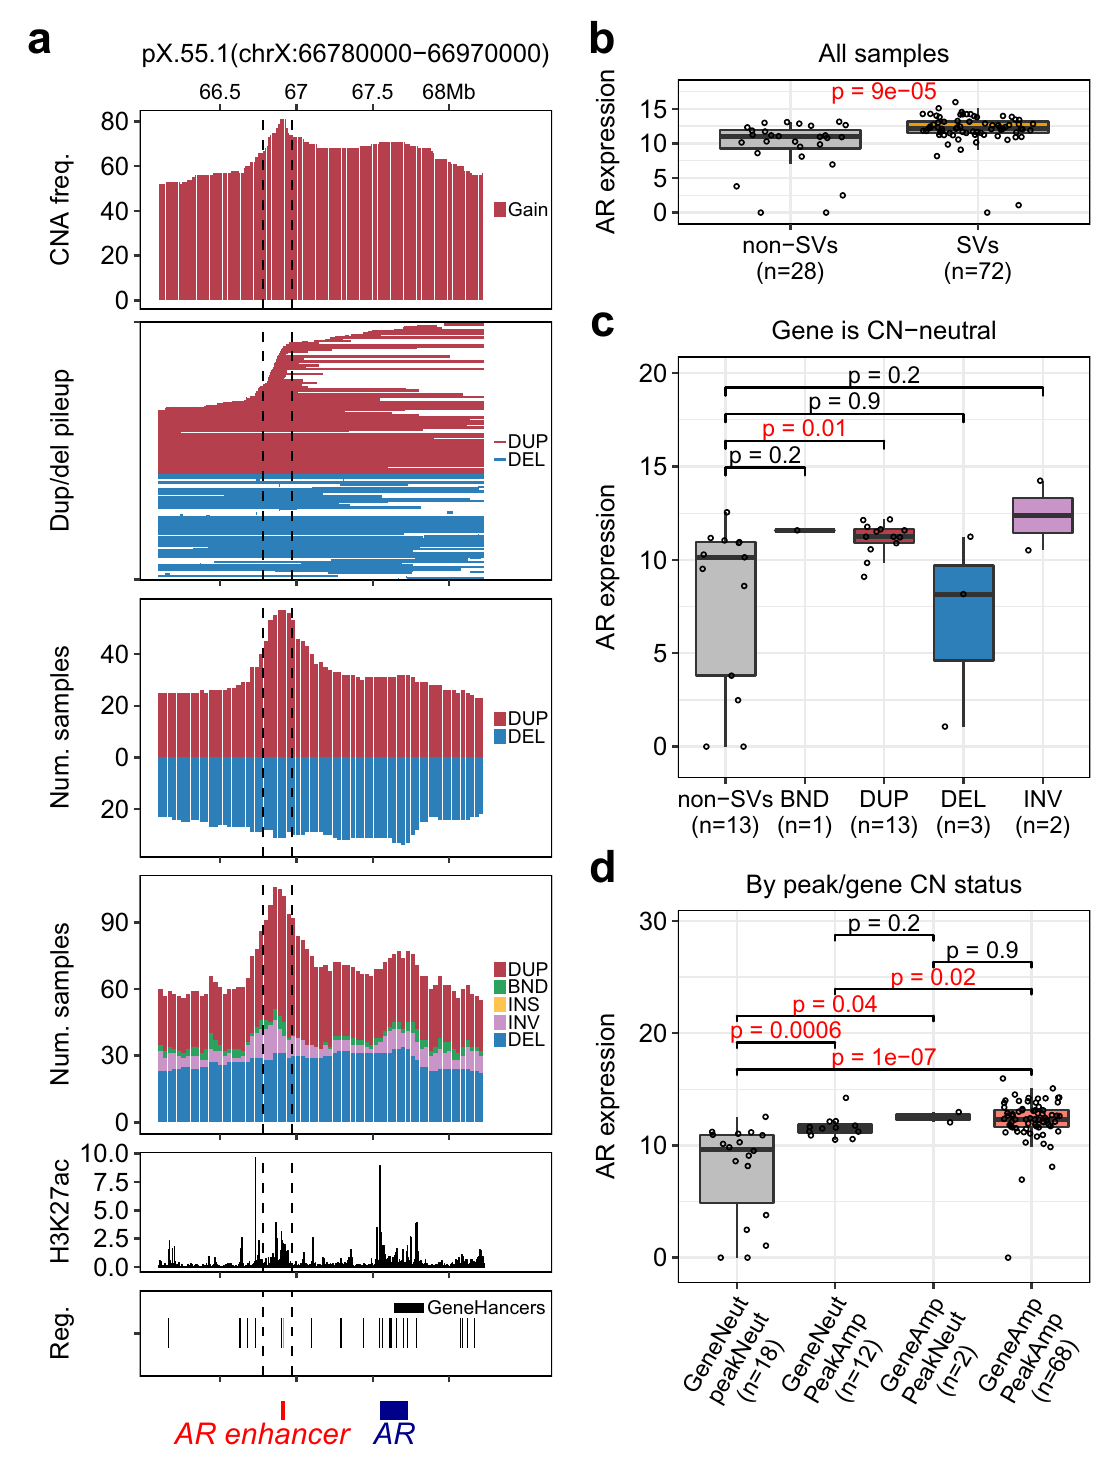
Figure 3. SV-HotSpot detects and visualizes recurrent SVs targeting the non-coding AR enhancer and is associating with increased AR expression. ( a ) Visualization of recurrent SVs targeting the peak (bounded by vertical dashed lines). From top to bottom are aggregation of copy number alterations, pileup of duplication/ deletion regions, aggregation of duplication/deletion regions, aggregation of all types of SVs, H3K27ac histone modification ChiP-Seq coverage, and enhancer annotation from Genehancer database. DUP—duplication, DEL—deletion, INS—insertion, INV—inversion, and BND—translocation ( b ) Comparison of AR expression between samples with SVs targeting the peak and those lacking SVs targeting AR enhancer peak. ( c ) Comparison of AR expression between samples with different types of SVs targeting the peak. ( d ) Comparison of AR expression between samples grouped by the presence/absence of copy number targeting AR gene body and the peak. The whole figure is the direct output of SV-Hotspot